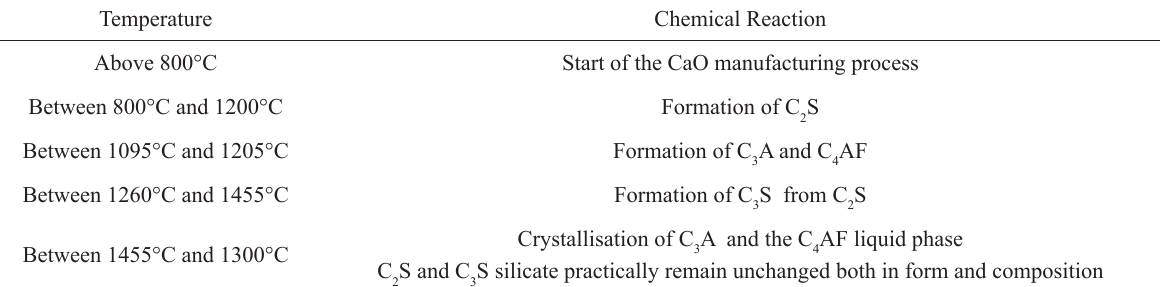
Temperatures of the chemical reactions of clinker production (Paula